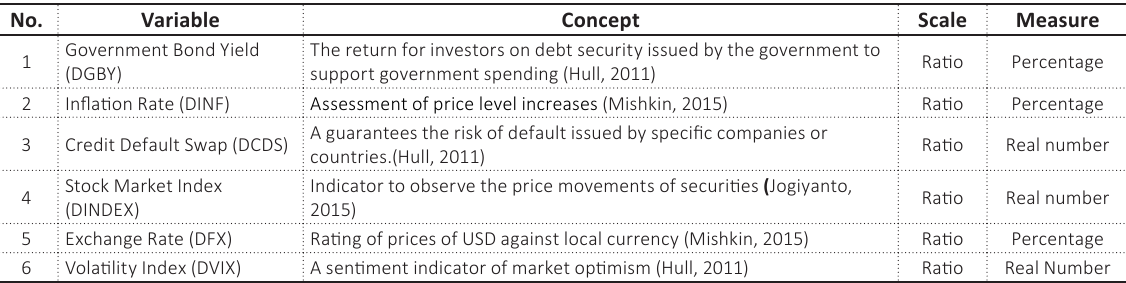
Table 1. Variable